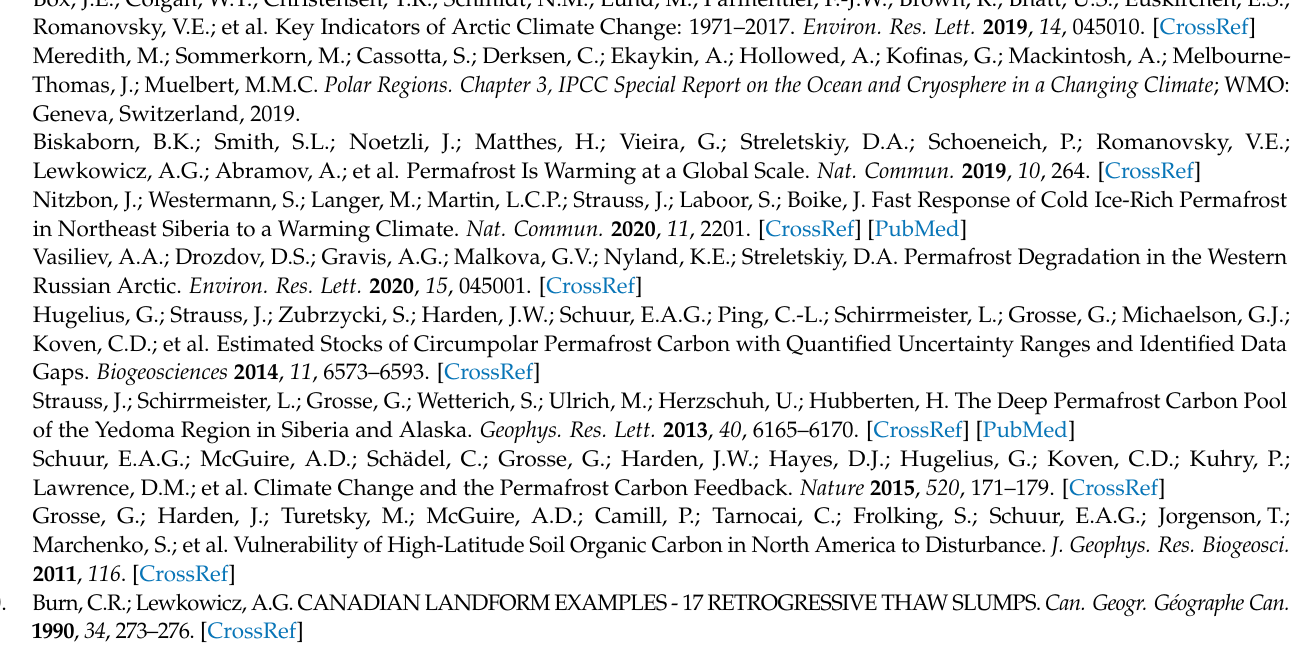
Figure A10. Mean and standard deviation of IoU scores per encoder sorted by ( a ) epoch and by ( b ) scores (best to worst). n = 18 (6 sites × 3 architectures) per encoder.